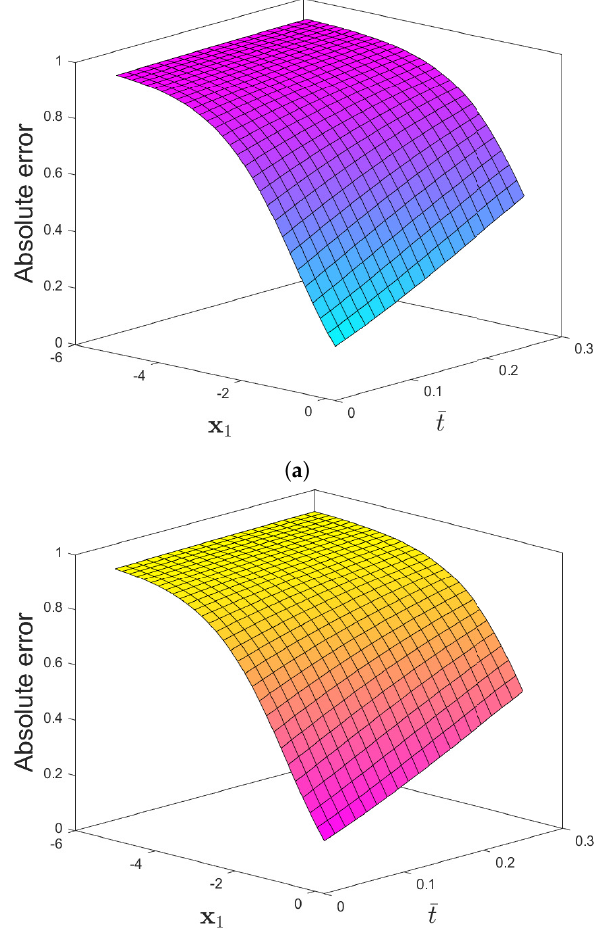
Figure 5. ( a ) Absolute-error plots of f ( x 1 , ¯ t ) for Problem 2 for ( a ) CFD and ( b ) ABC when the parameters are θ = 6, β = 1, and ϕ = 0.